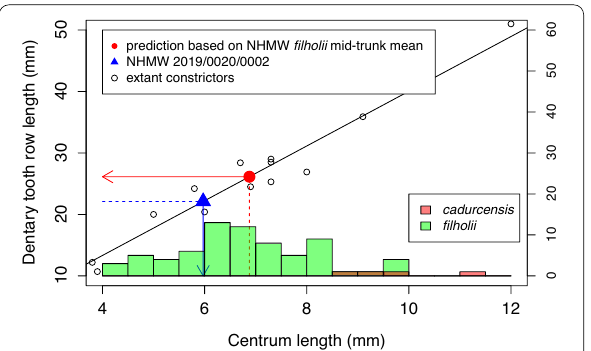
Fig. 87 Distribution of centrum length (CL) in NHMW sample of Palaeopython cadurcensis and Phosphoroboa filholii comb. nov. (frequency counts on right axis). Superimposed is the relationship between dentary tooth row length and mid-trunk vertebral centrum length (CL) in extant Constrictores (dentary size on left axis). Centrum length indicated by the dentary NHMW 2019/0020/0002 from the same sample and dentary tooth row length indicated by the population mean of Phosphoroboa filholii comb. nov. mid-trunk vertebrae support the referral of the dentary to Phosphoroboa filholii comb. nov.